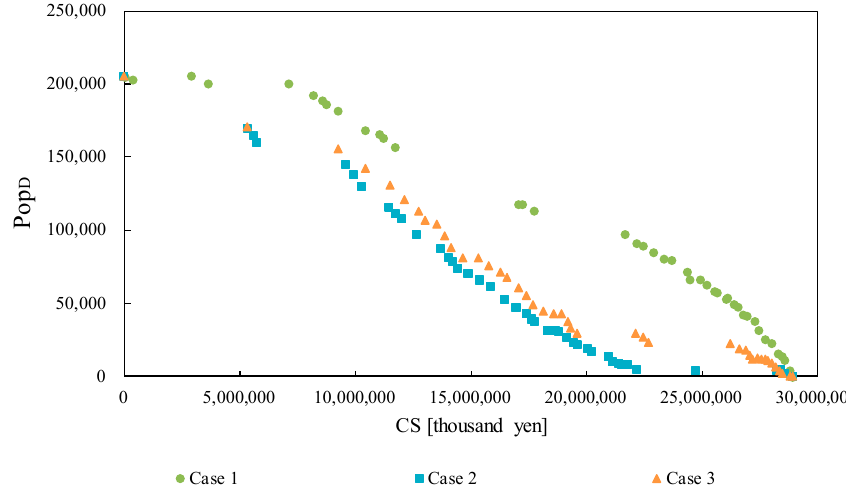
Figure 6. The relationship between water outage population ( P D ) and renewal costs of water pipelines ( CS ) that are required for the constructions for the earthquake-resistance countermeasures.